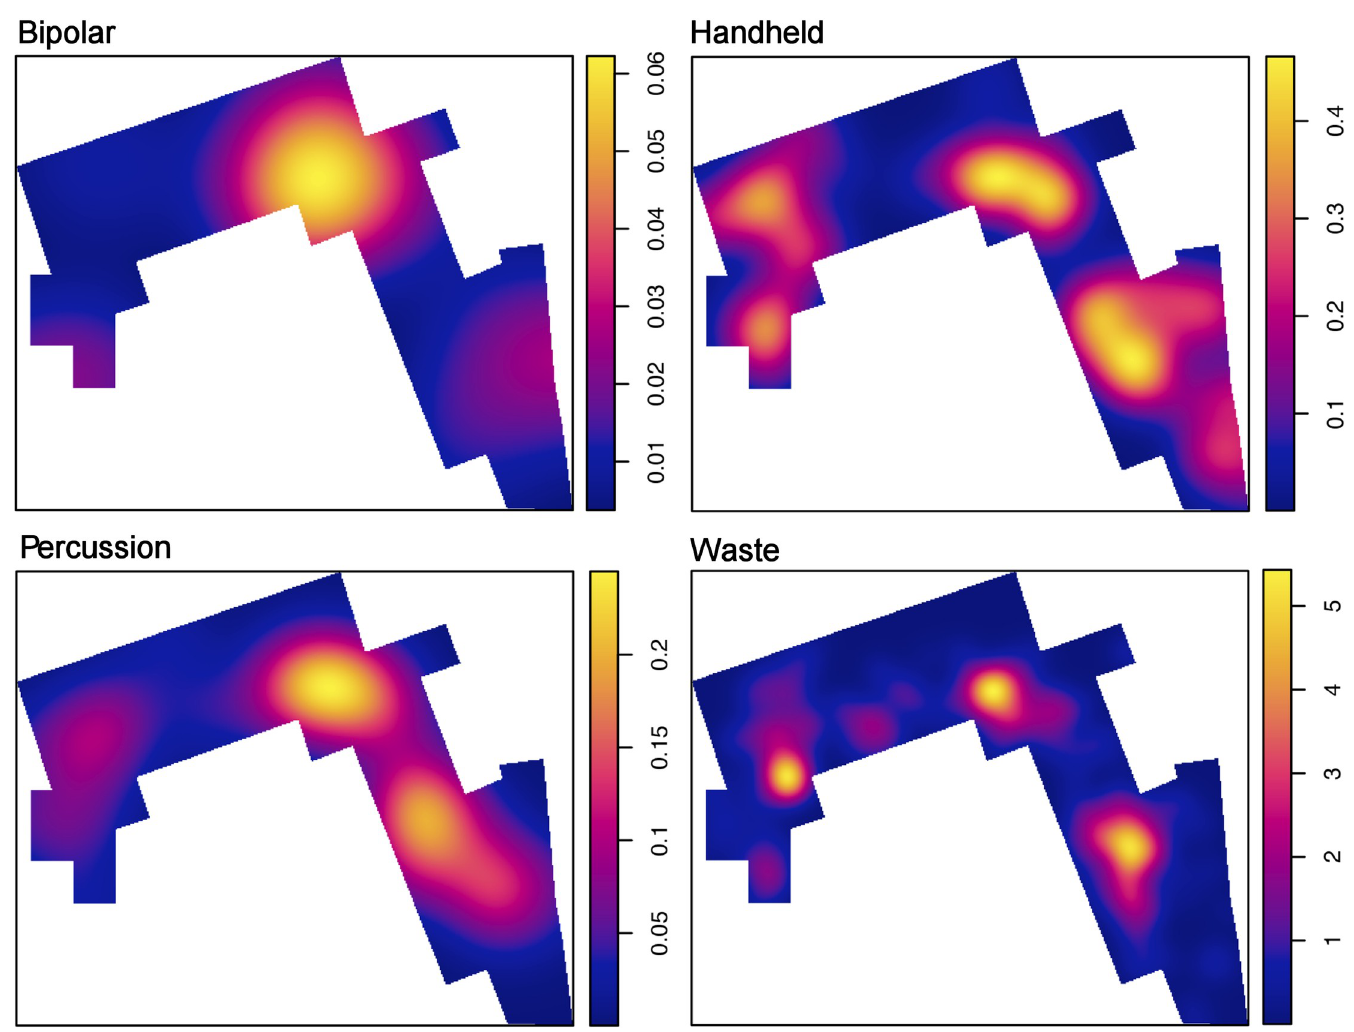
Fig 14. Density maps of bipolar, handheld, percussion and waste